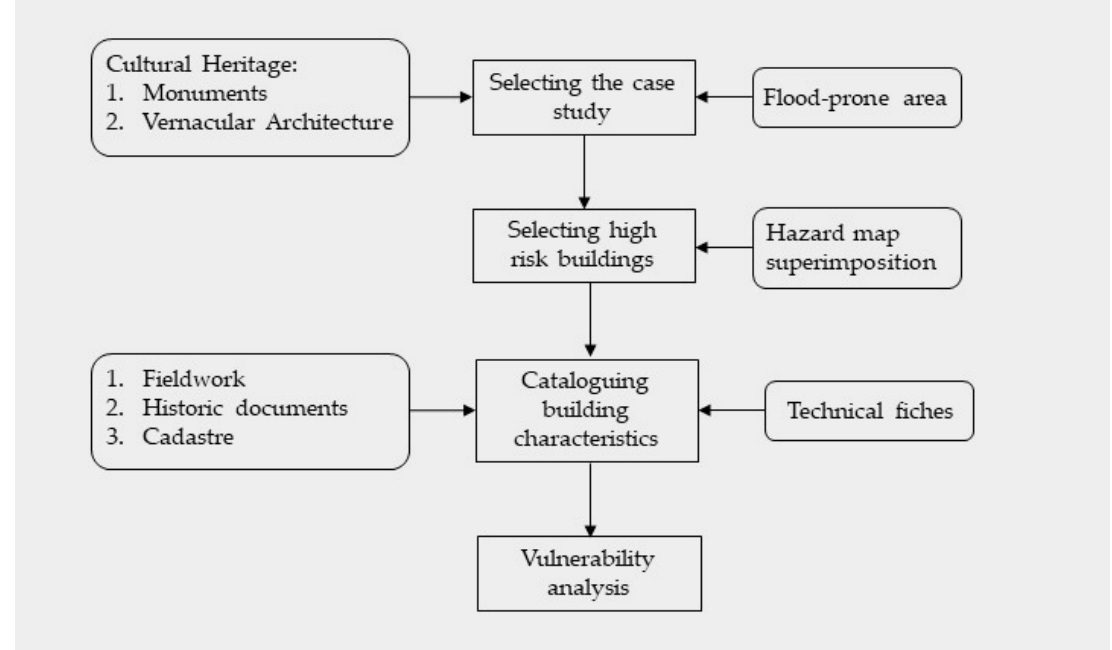
Figure 5. Methodological map.